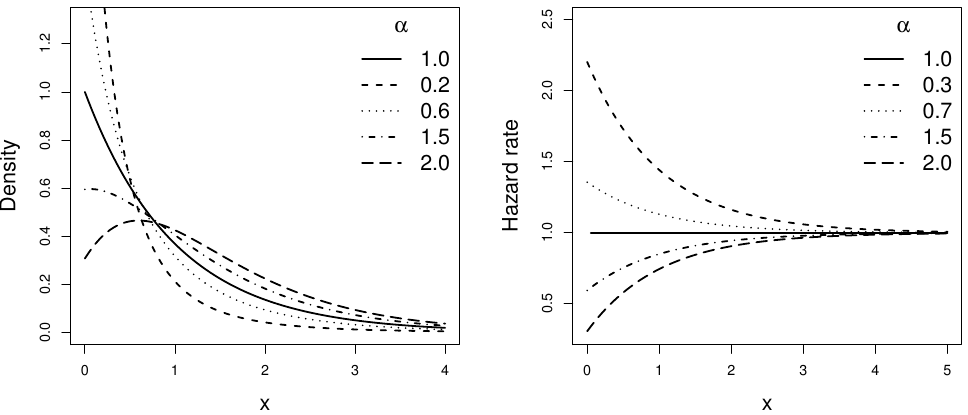
Figure 1. Plots of the density and hazard rate functions of the LE distribution for σ = 1 and different values of α .